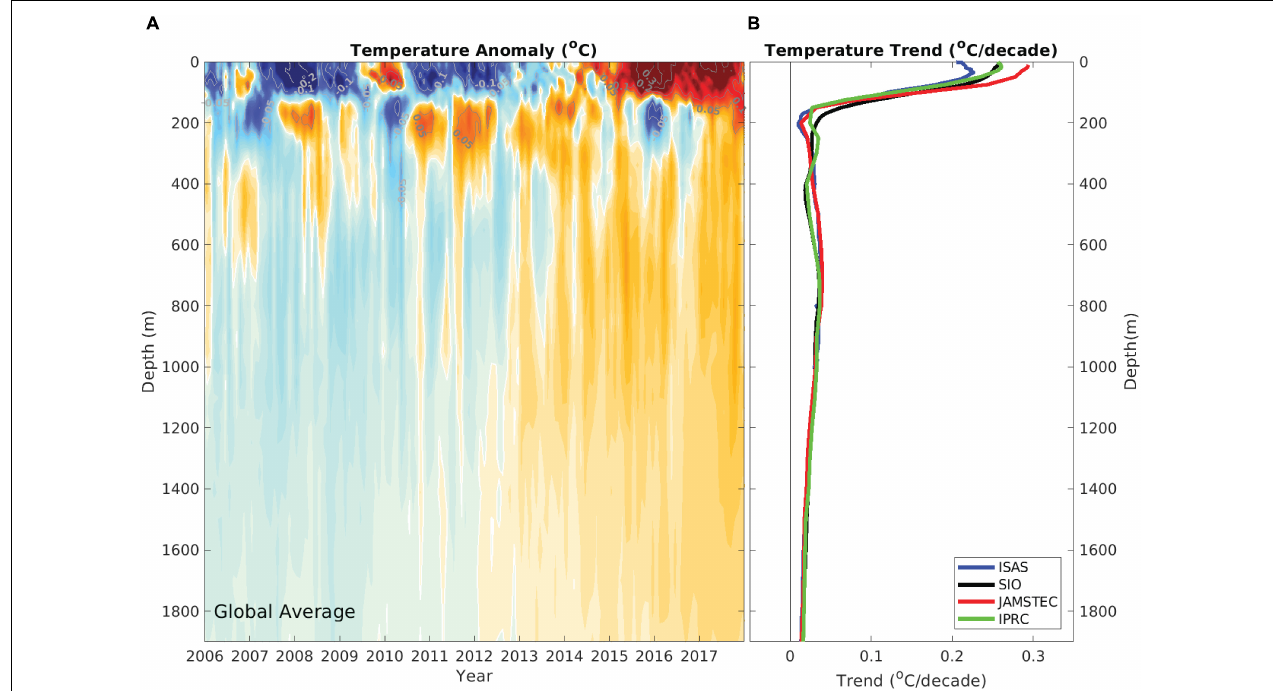
FIGURE 12 | (A) Global averaged temperature anomaly ( ◦ C – from SIO) and (B) trend ( ◦ C/decade, 2006–2018) versus depth, based on gridded Argo data. Gridded product sources are: ISAS (Gaillard et al., 2016), SIO (Roemmich and Gilson, 2009); IPRC- from the Asia-Pacific Data Research Center (http://apdrc.soest.hawaii.edu/projects/Argo/data/gridded/On_standard_levels/index-1.html); JAMSTEC (Hosoda et al., 2008).